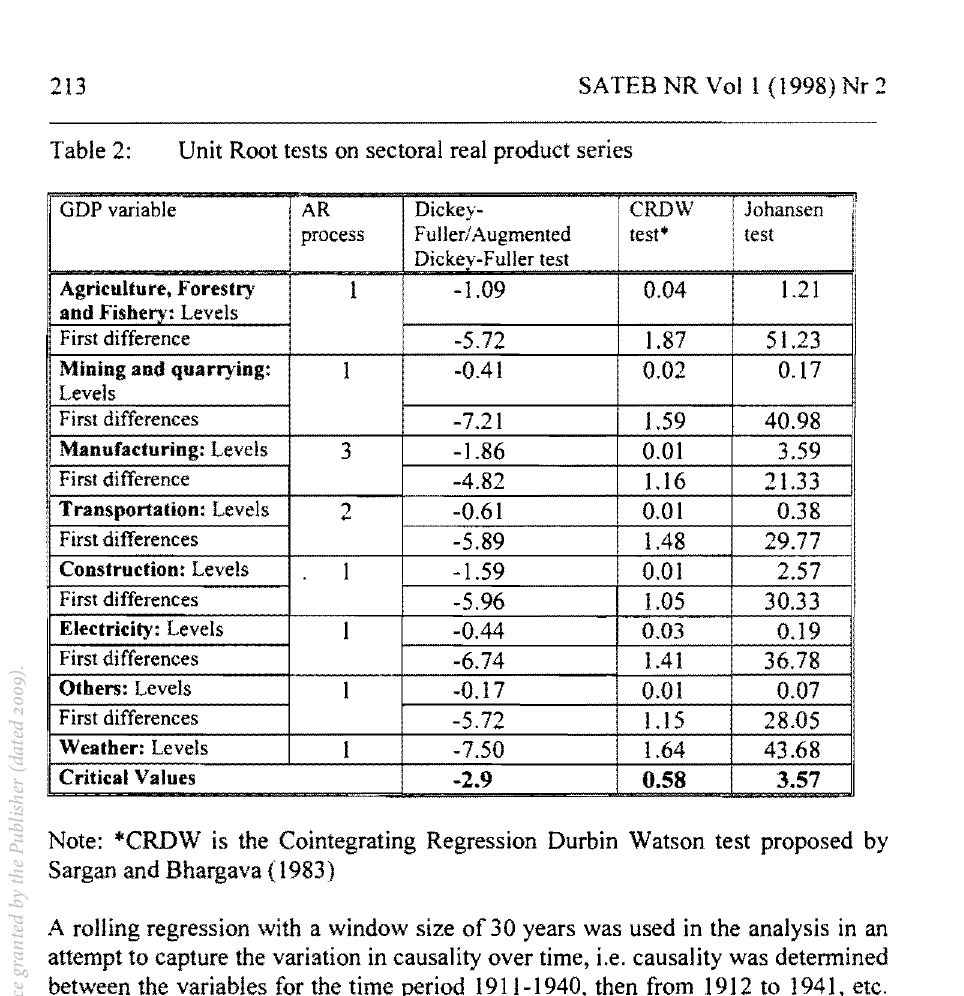
Unit Root tests on sectoral real product